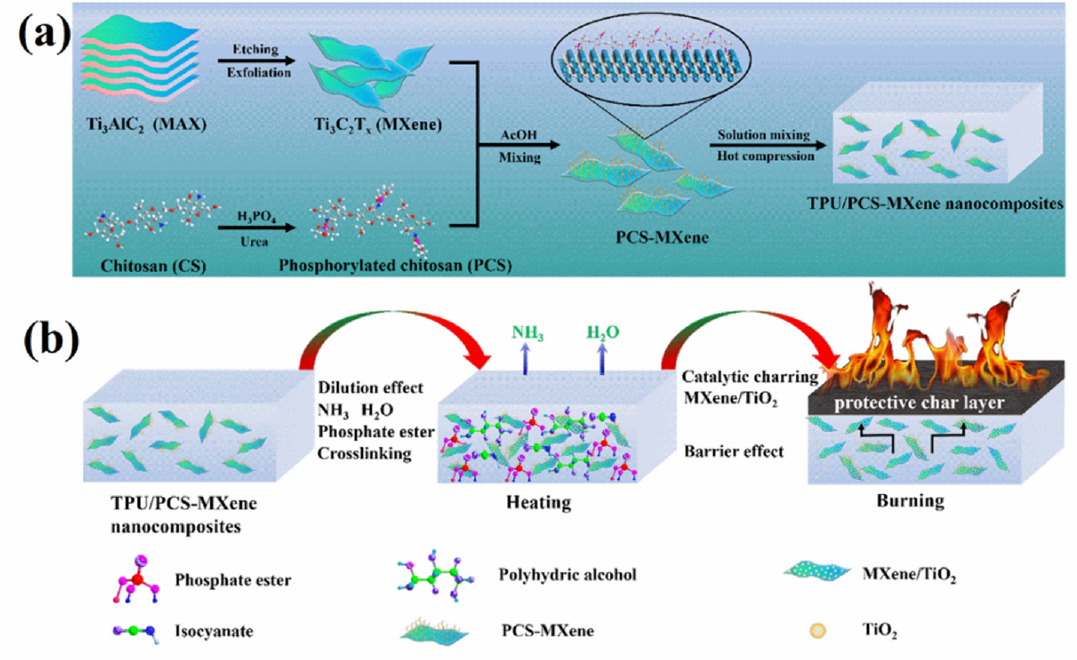
Figure 9. ( a ) Illustration of the preparation and ( b ) possible flame-retardant mechanism of TPU/PCS- MXene nanocomposites (Reprinted with permission from Ref. [80]. Copyright 2022, copyright Else- vier).